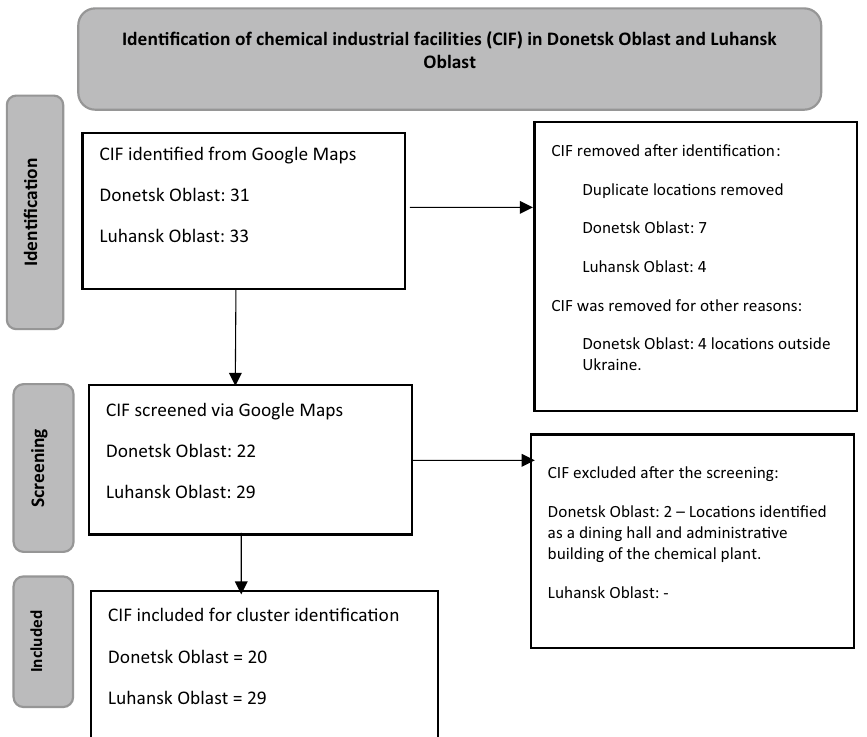
Figure 2. Process of chemical industrial facility identification in Eastern